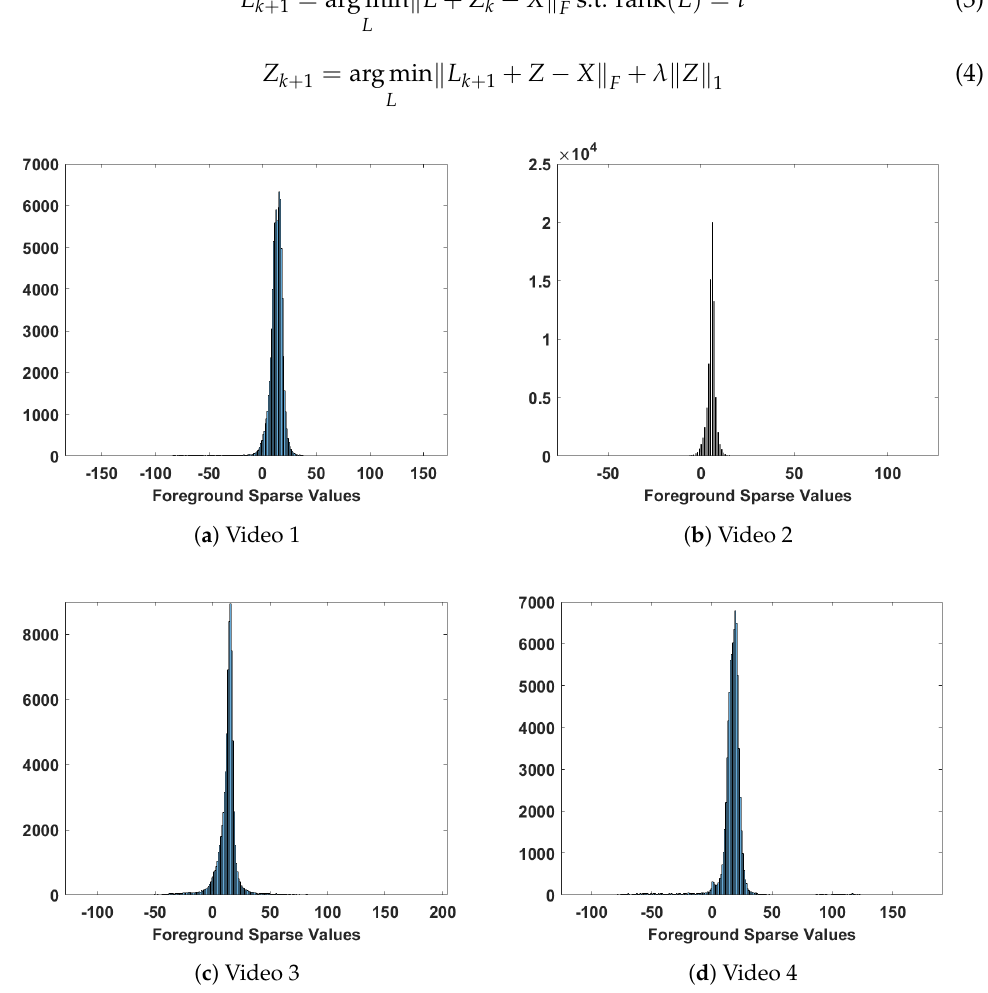
Figure 3. A sample histogram of extracted sparse background for different dataset